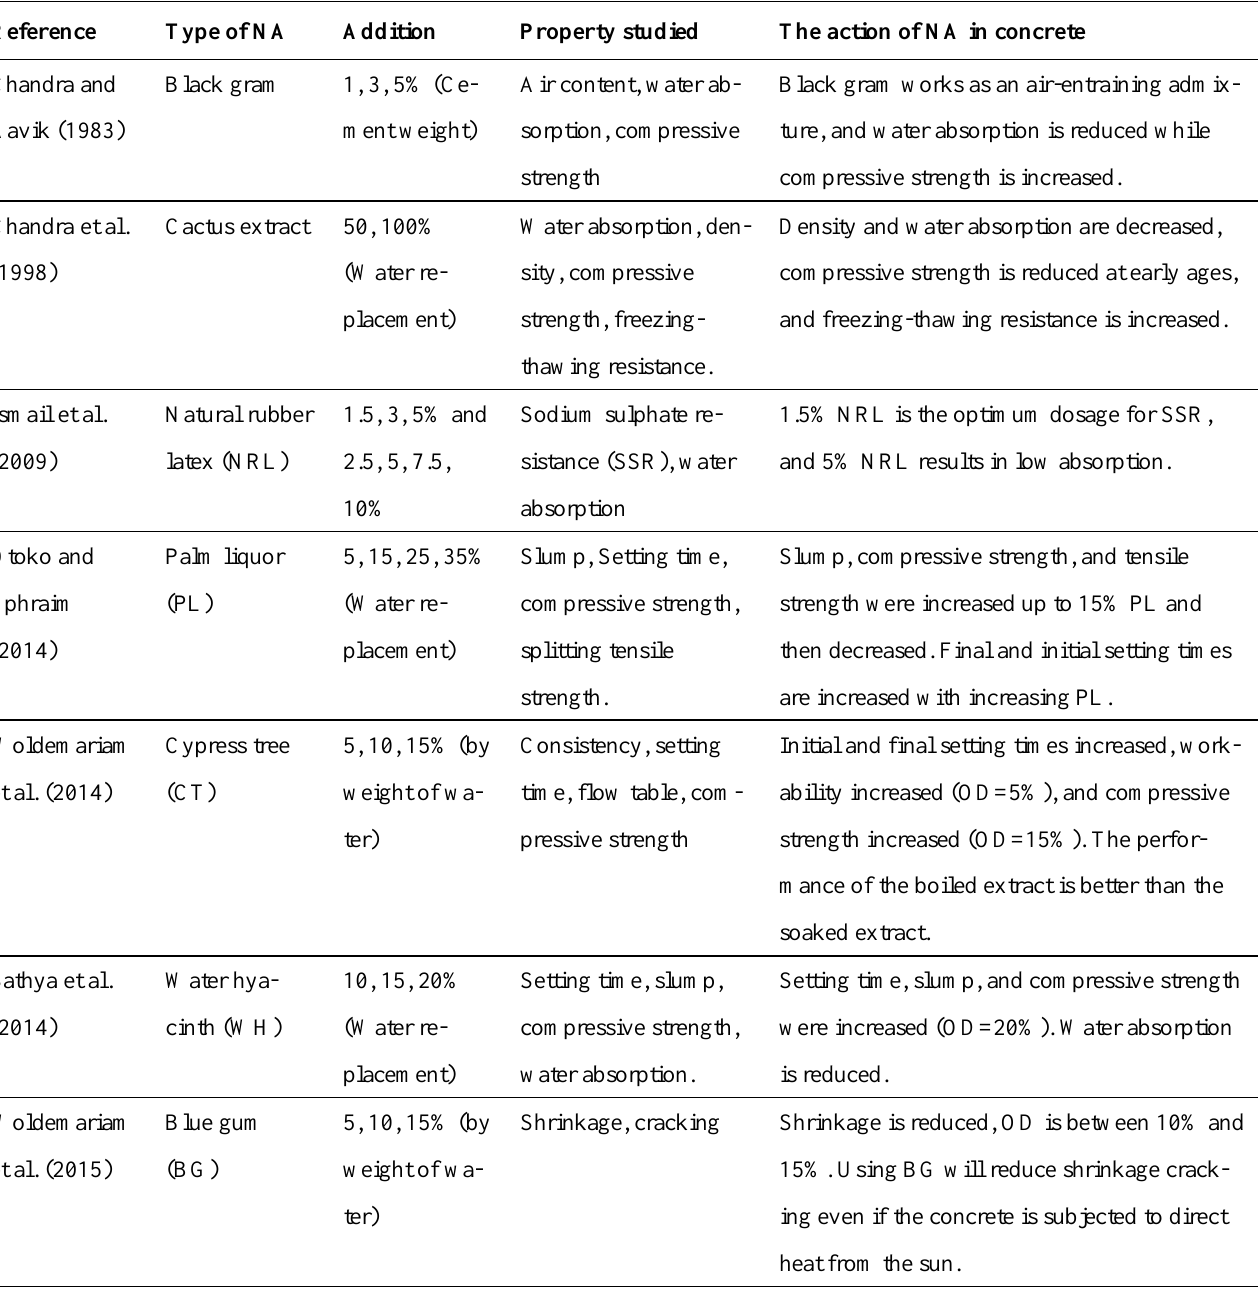
Table 1 . The Attributes and Data Types of Training